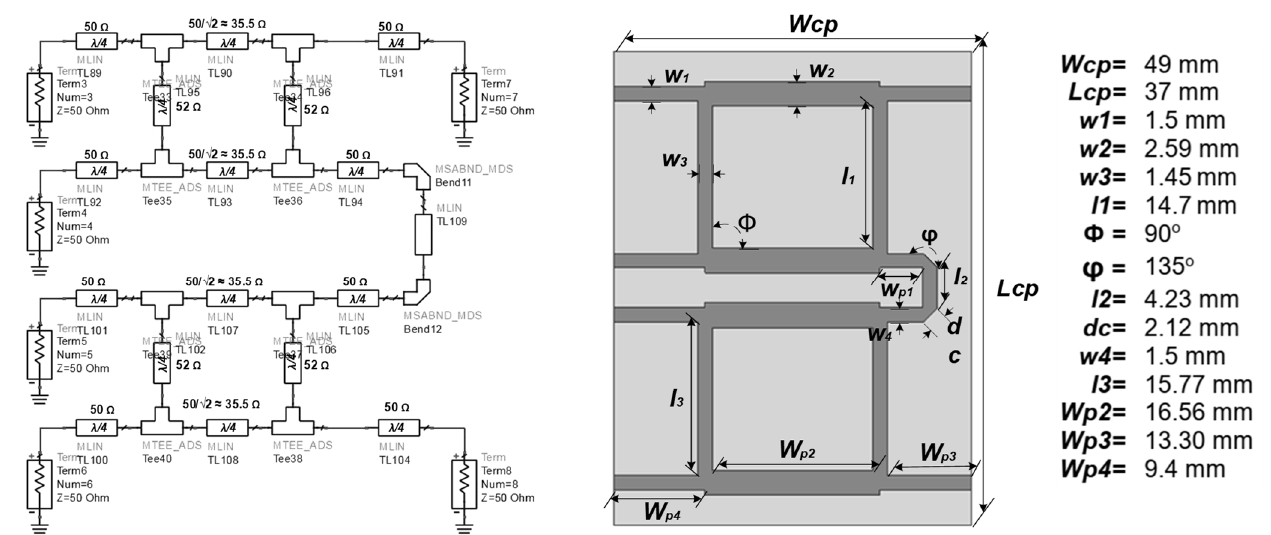
Figure 5. Stub Geometry on the 2 × 4 Direction-Finding Hybrid Coupler.